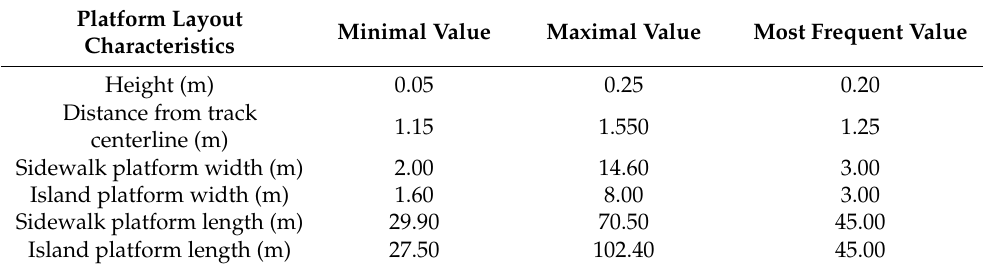
Table 1. Layout characteristics of single-stop platforms.